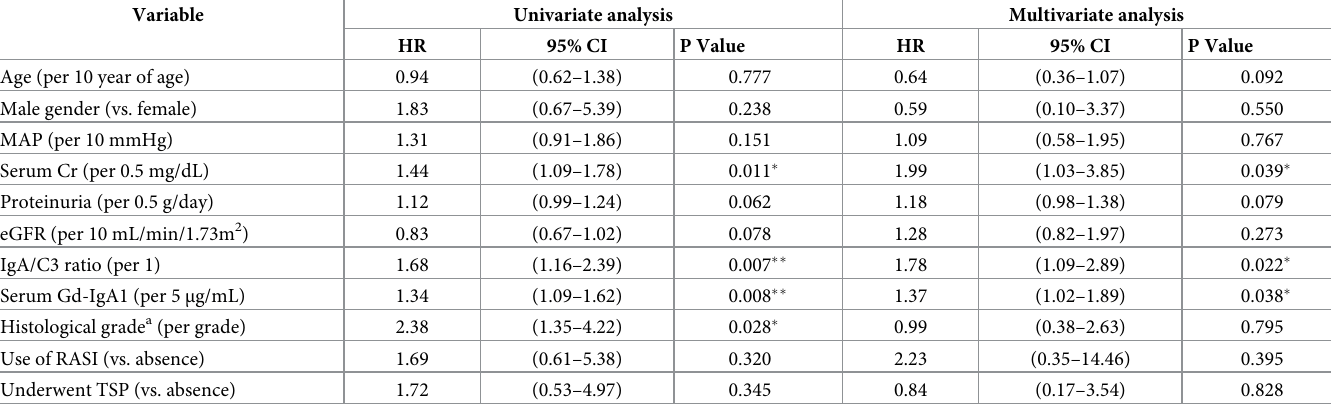
Table 3. Univariate and multivariate analysis of possible factors that contributed to 30% eGFR reduction in 111 patients with